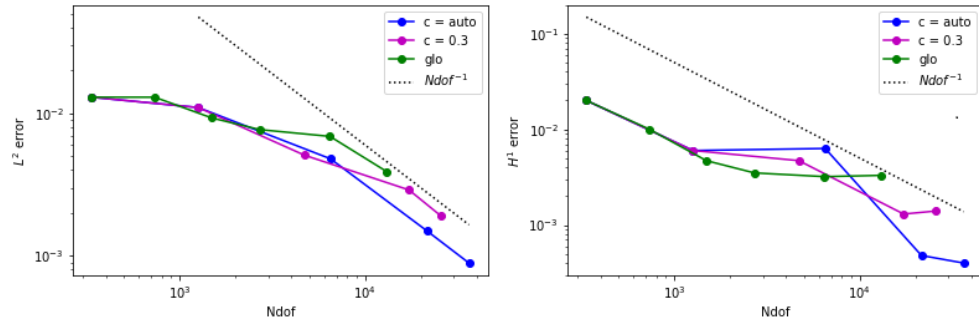
Figure 8. Error behavior for example 1 when η N is adopted. ( Left ) The estimated L 2 norm of the error is displayed. ( Right ) The estimated H 1 seminorm is shown.